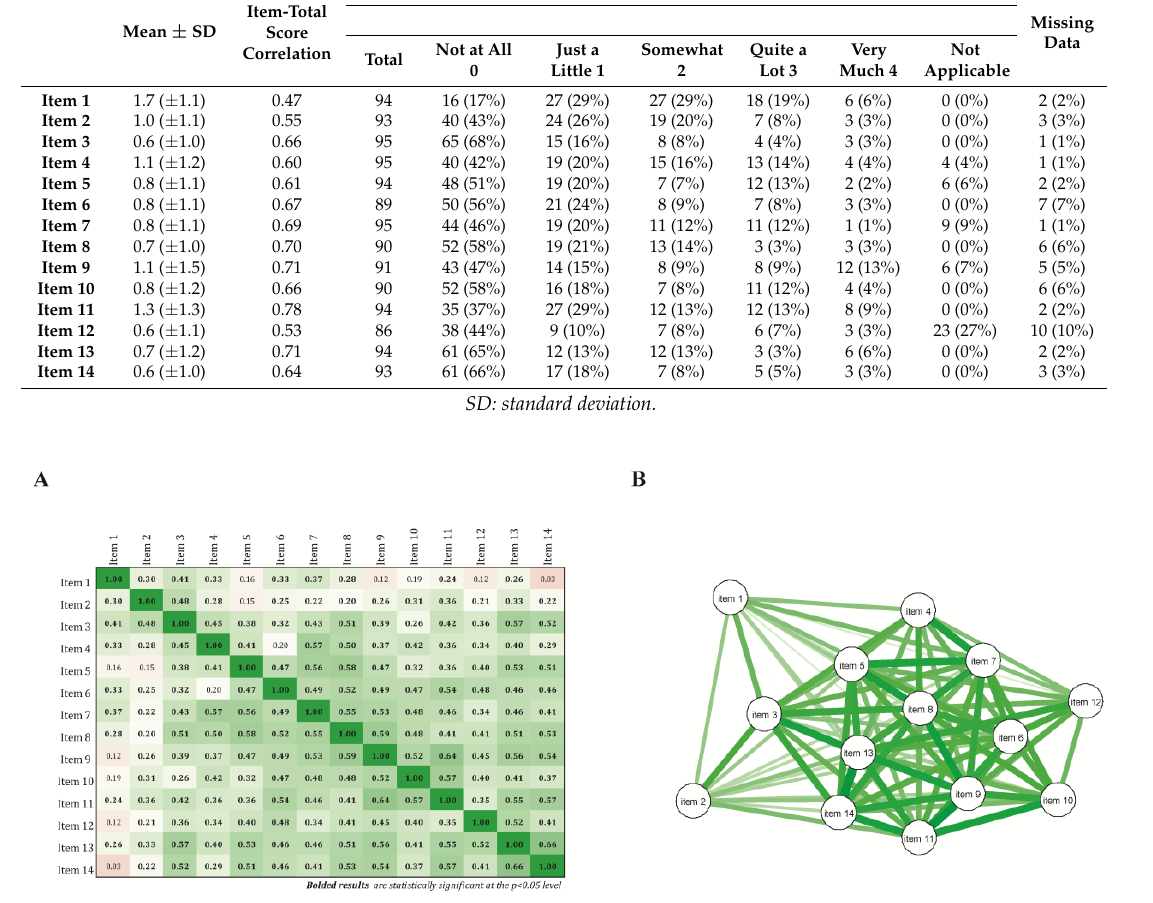
Figure 1. Correlation between items: ( A ) Spearman’s rank correlation coefficients matrix and ( B ) correlation network. The matrix contains the Spearman’s rank correlation coefficients between the 14 items of the candidate questionnaire. Colors indicate the direction and the strength of the correlation, with positive correlations being displayed as green tones and negative ones as red tones. Bolded results indicate statistical significance at the p < 0.05 level. The correlation network is constructed from all pairwise correlations between items in ( A ). Items are represented by nodes and are connected by edges. Red and green lines represent negative and positive correlations, respectively. Line width color saturation is proportional to the strength of the correlation.